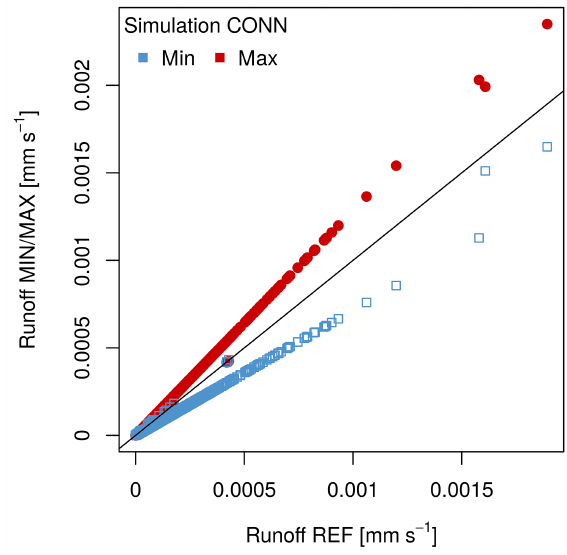
Figure 5. Comparison of total urban runoff ( R town ) between the ref- erence simulation (REF) and the MIN (blue) and MAX (red) simu- lations for parameter f con .